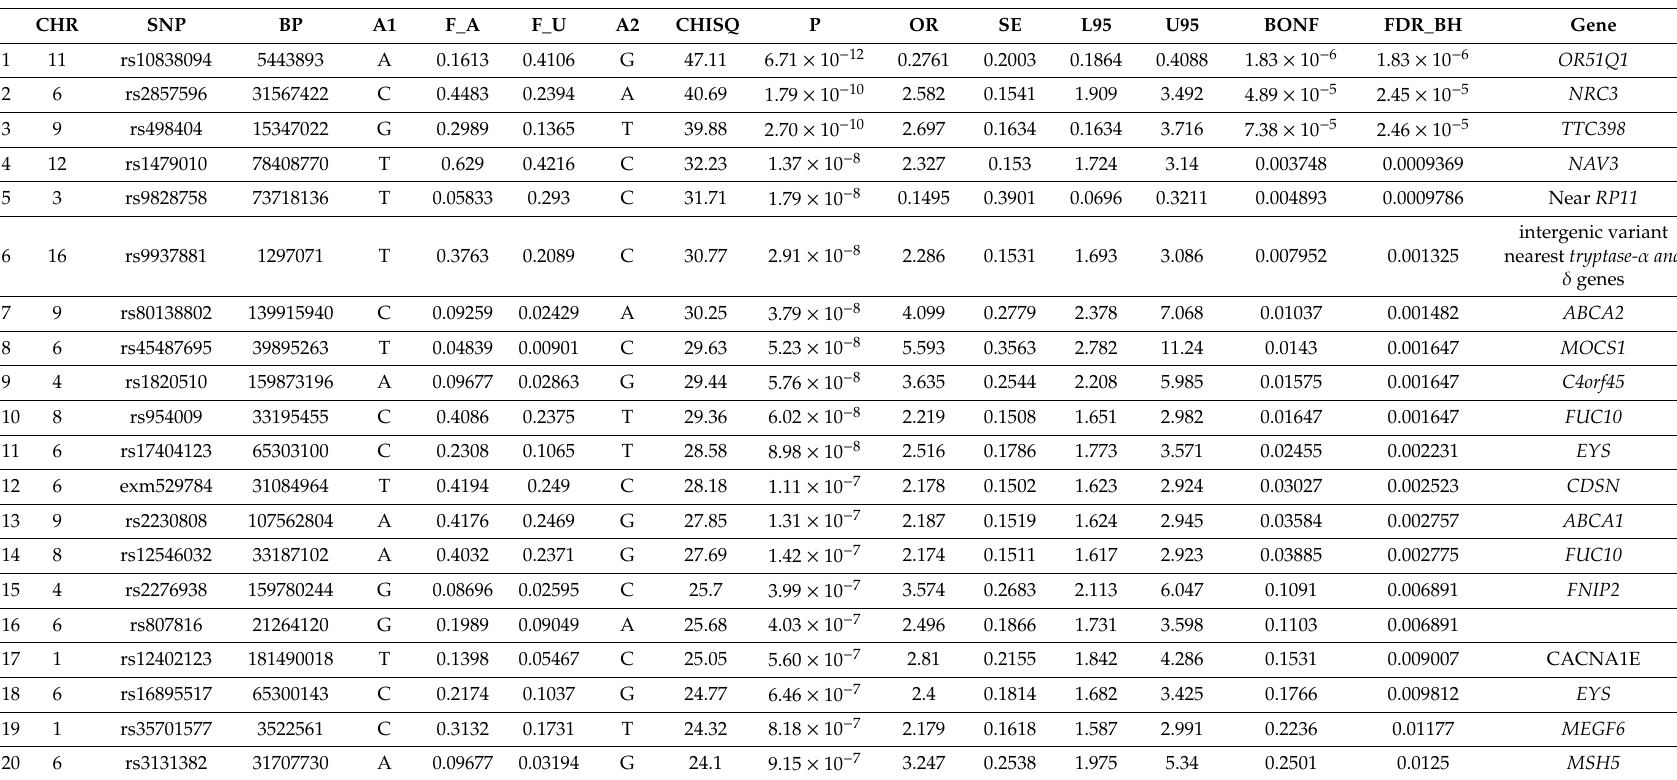
Table legend: CHR—chromosome, BP—base pair based on the human reference genome GRCh37, A1—minor allele, A2—major allele, F_A—frequency of A1 allele in patients, F_U—frequency of A1 allele in controls, CHISQ—basic allelic test chi-square (1df), P— p -value for CHISQ, OR—odds ratio, SE—standard error, L95 and U95—95% confidence interval